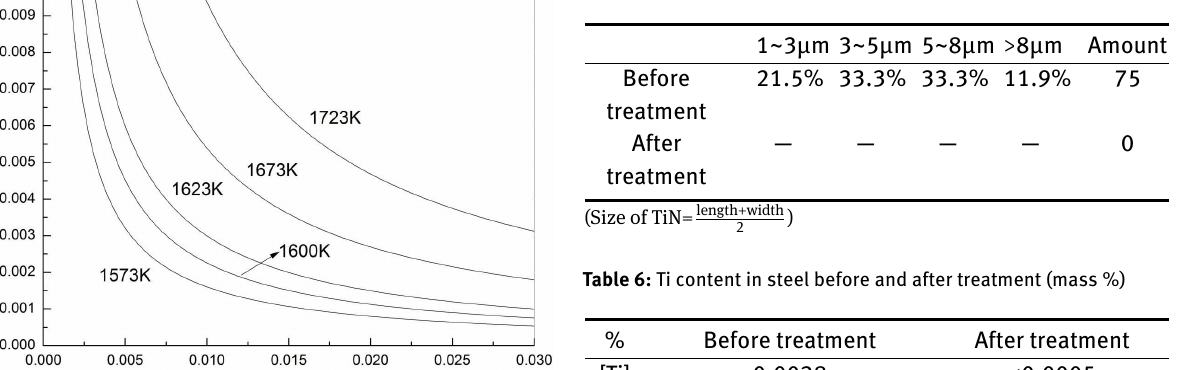
Table 5: Amount and size distribution of TiN inclusion